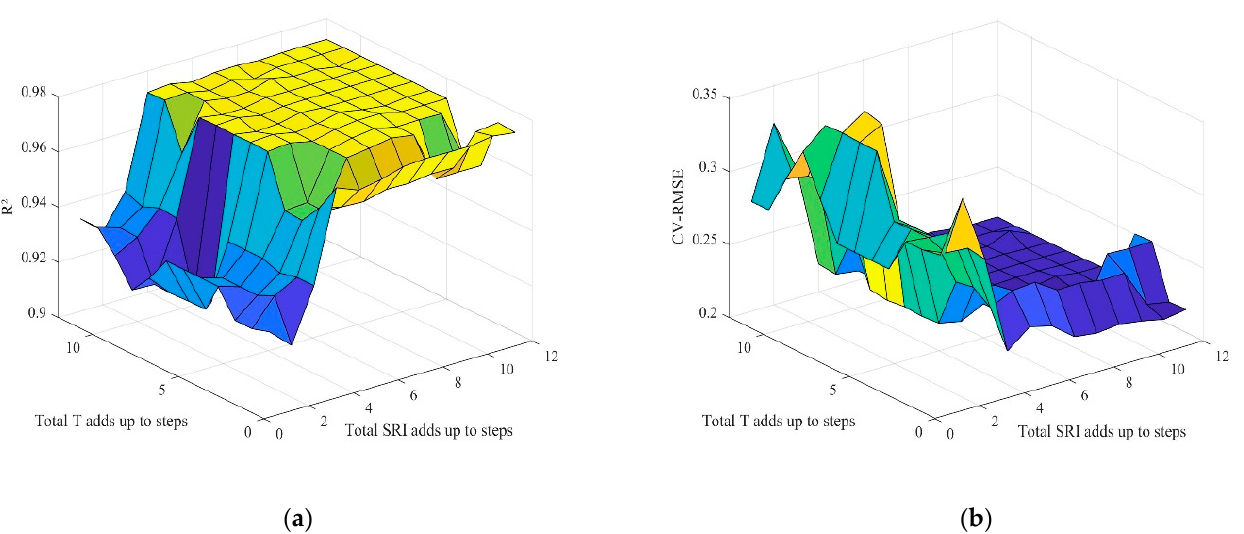
Figure 7. Accuracy index of the Gaussian process regression model with grid searching method. ( a ) R 2 . ( b )